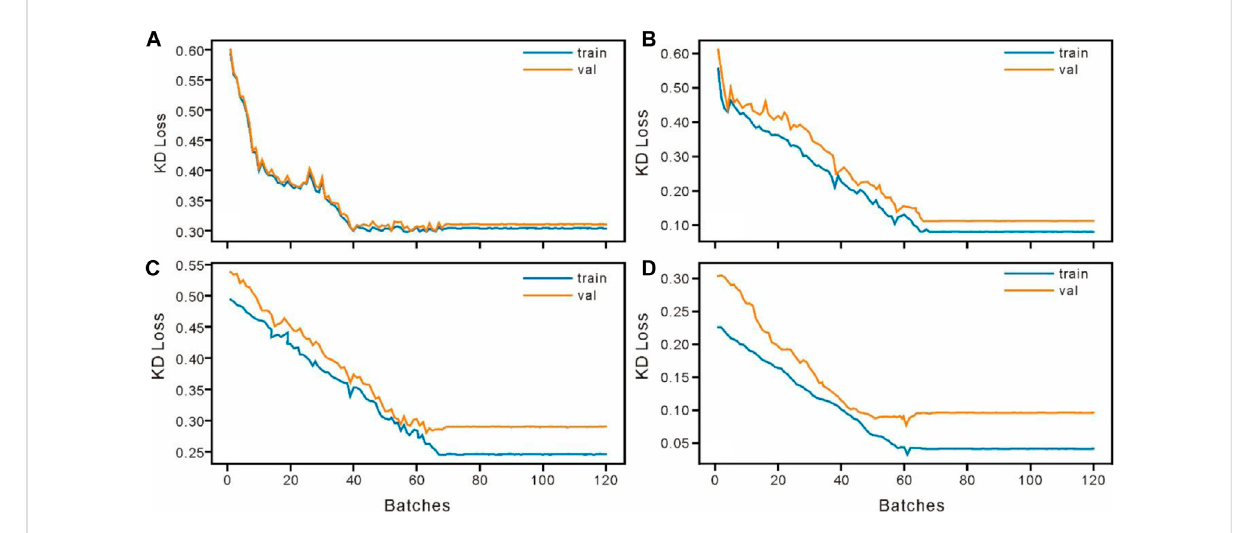
FIGURE 5 Thedistillationtrainingandvalidationdatasets(consideringnobiasindifferentstages,theparameters α and β inthedistillationlossaresetas0.5. Each batch has 10 epochs) (A) Stage 1; (B) Stage 2; (C) Stage 3; (D) Stage